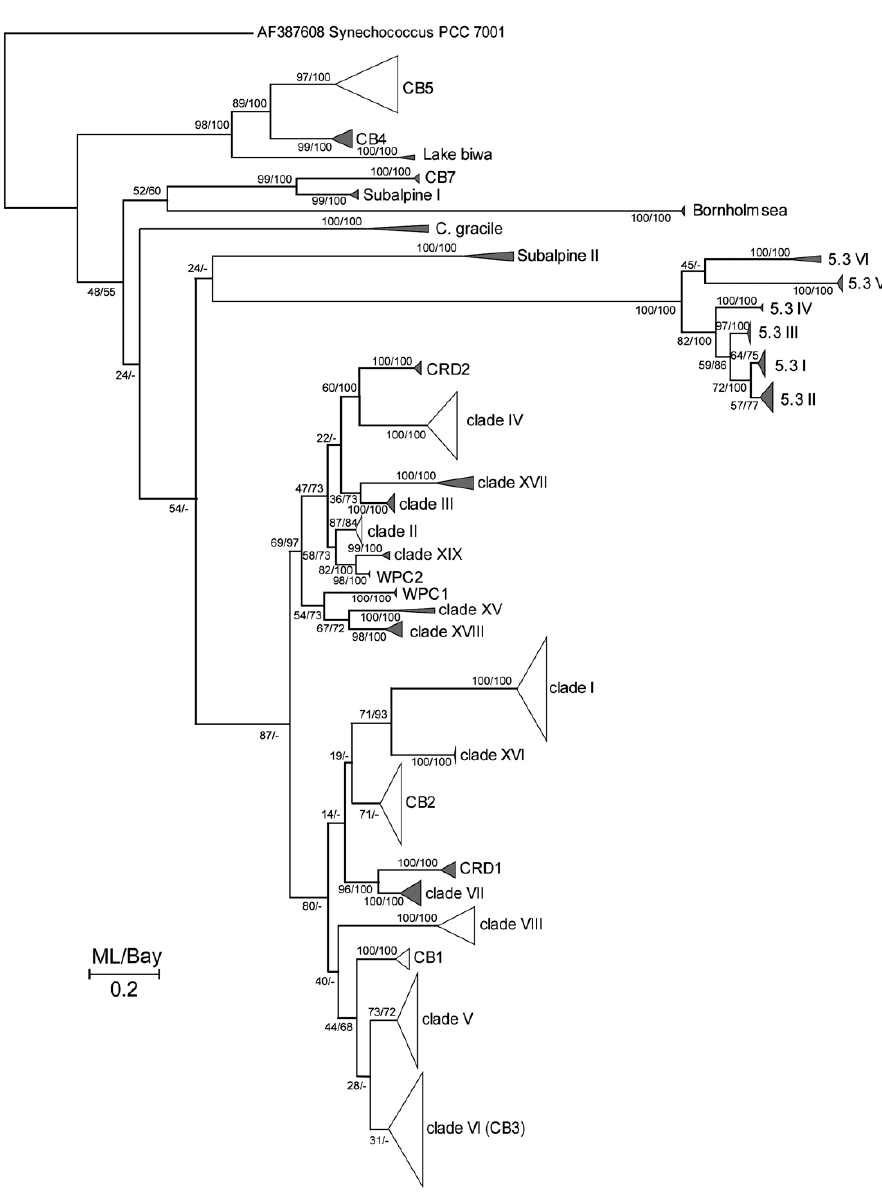
Figure 5. A phylogenetic tree of the Synechococcus internal transcribed spacer (ITS) region of 16S– 23S rDNA sequences, showing consensus topology obtained using maximum likelihood (ML) and Bayesian inference. The ITS sequence of strain PCC 7001 was used as the out-group. Open triangles indicate that the clades included sequences newly obtained in the present study. Both bootstrap values of ML and posterior probability (Bay) are shown at the nodes in percentage. Only nodal supports higher than 50% are shown. The scale bar indicates 20 nucleotide substitutions per 100 sites.